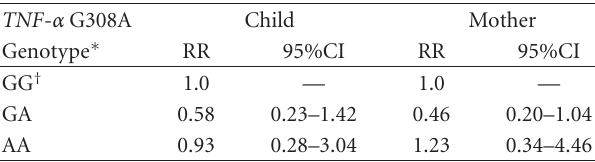
Table 4: Associations of maternal and fetal TNF - α gene G308A genotypes with preterm delivery.